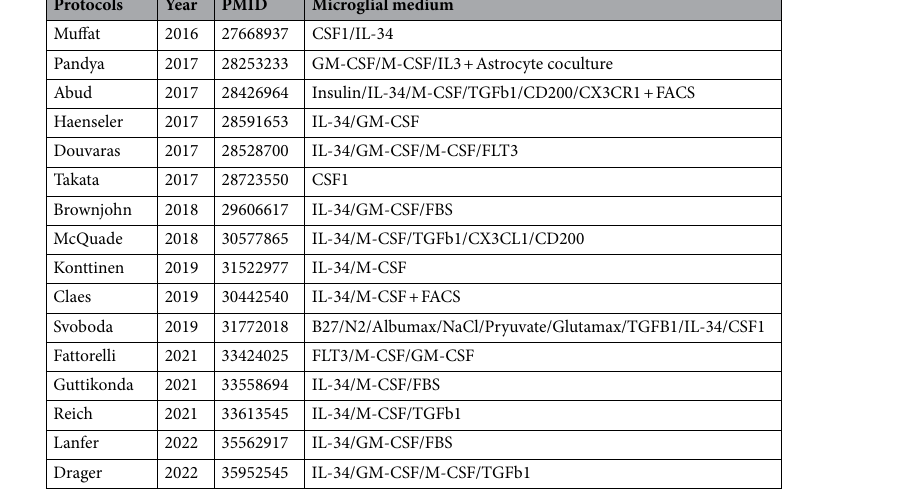
Table 1. Published media for differentiating iPSC to